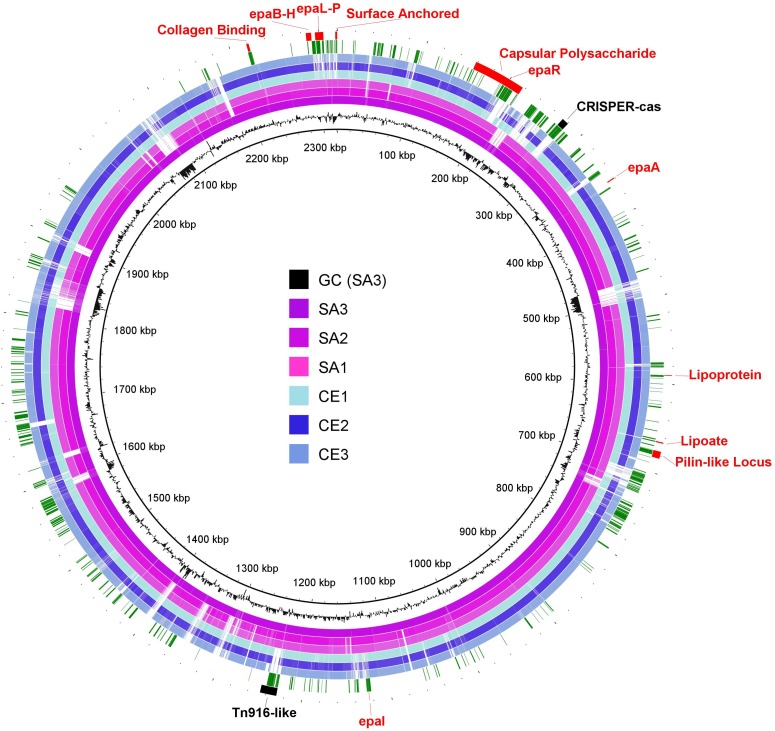
Predicted Proteins Highly Conserved in Pathogenic EC Mapped to Genome Assemblies of EC.Pathogenic (magenta) and commensal (blue) EC scaffolds were mapped to SA3 (including SA3 as a control) using BRIG ring generator and BLASTn. GC content of SA3 is plotted in black on the innermost ring. Increased GC content is represented by peaks toward the center of the circle and decreased GC content is represented by peaks away from the center. Genetic sequences of less than 50% homology are plotted in white on each ring. Outside the chromosomal rings and identified by green bars, are the genomic locations of the 414 predicted proteins with >98% identity in pathogenic strains and with <98% identity in commensal strains. Potential mediators of virulence are identified in red and include the capsular polysaccharide locus, epa-like genes and putative surface expressed proteins that may bind host substrates. Identified in black are the CRISPER-cas and Tn916-like regions.